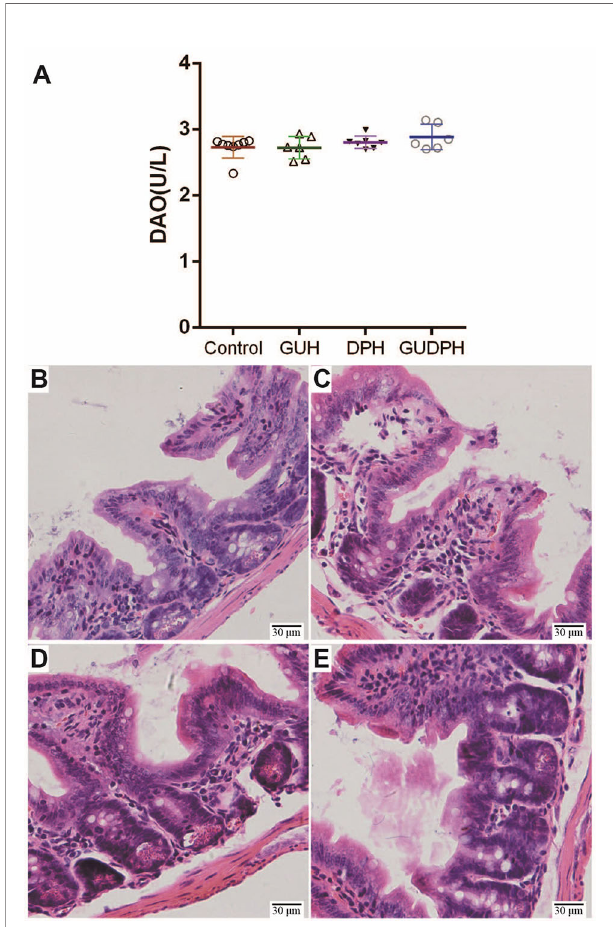
FIGURE 6 | Serum DAO levels and HE staining of ileum tissues in mice treated simultaneously with antibiotics and herbal extracts. (A) Mouse serum DAO levels in each group. (B) HE staining of mouse ileum tissue slices in Control group. (C) HE staining of mouse ileum tissue slices in GUH group. (D) HE staining of mouse ileum tissue slices in DPH group. (E) HE staining of mouse ileum tissue slices in GUDPH